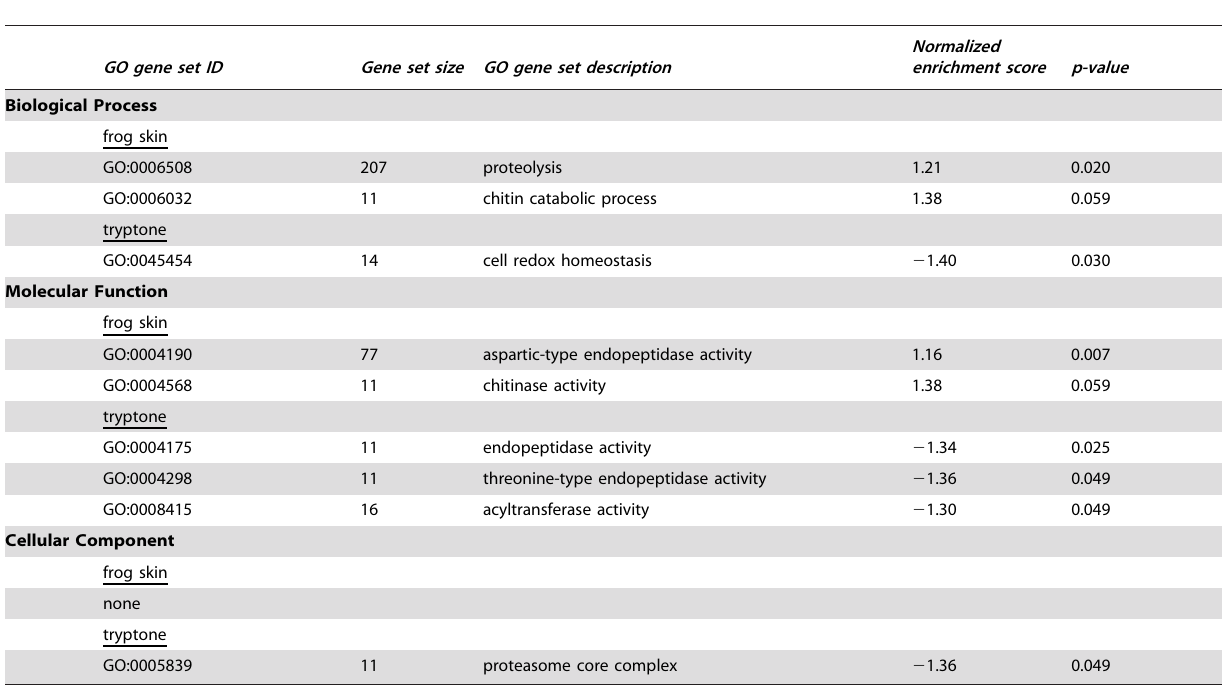
Table 1. The enrichment of Gene Ontology (GO) categories for the frog skin and tryptone treatments.